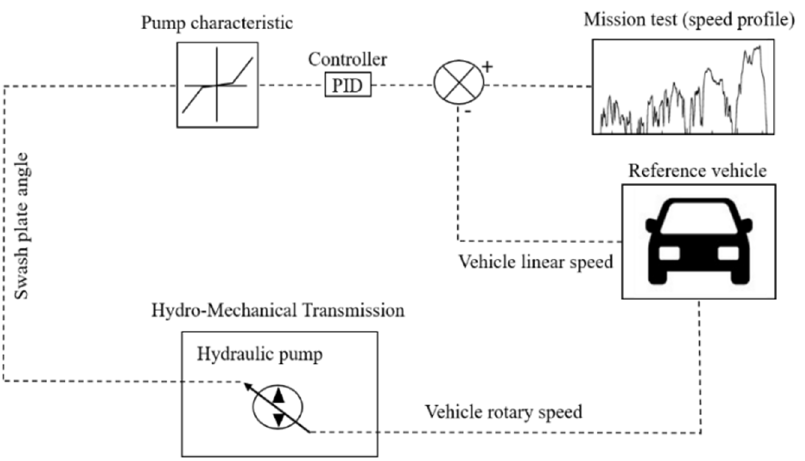
Figure 9. Pump displacement control strategy.